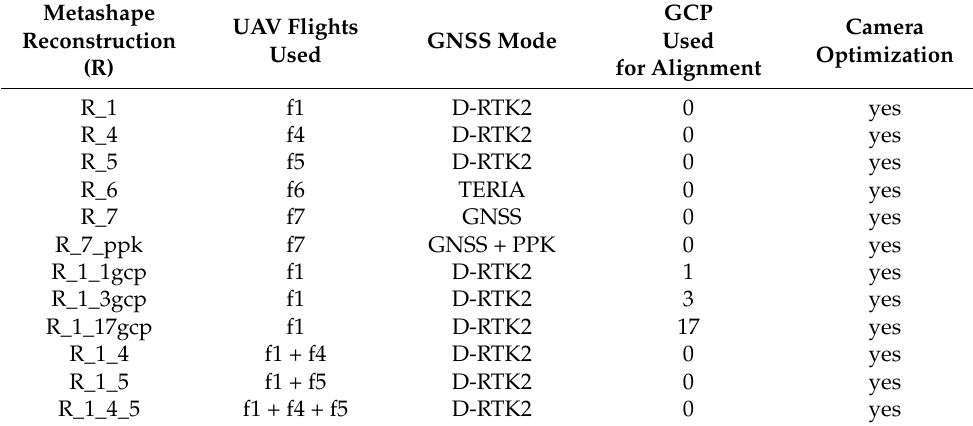
Table 4. The 12 reconstructions that were computed with Agisoft Metashape.